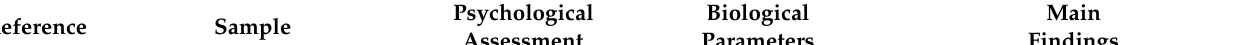
Table 1. Neuroimaging and cognitive